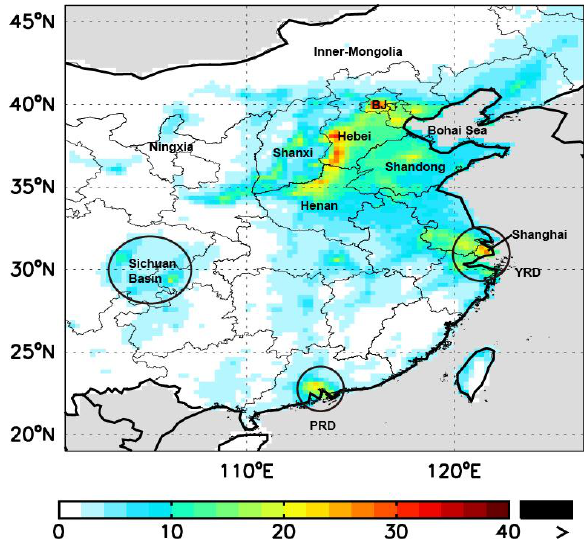
Fig. 1. Regional specifications with provincial boundaries for East China. Also presented are its subregions, provinces and province- level municipalities discussed in the text: the Yangtze River Delta (YRD), the Pearl River Delta (PRD), the Sichuan Basin, the Bo- hai Sea, Beijing (BJ), Shanghai, Hebei, Henan, Shandong, Shanxi, Ningxia, Inner-Mongolia, and Sichuan. On the background is the annual mean VCDs of NO 2 from the DOMINO-2